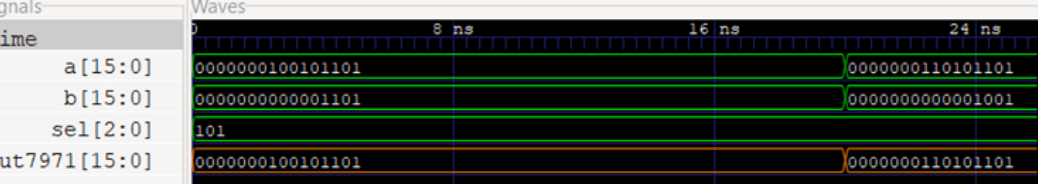
Figure 17. Waveform results of the bitwise OR module.